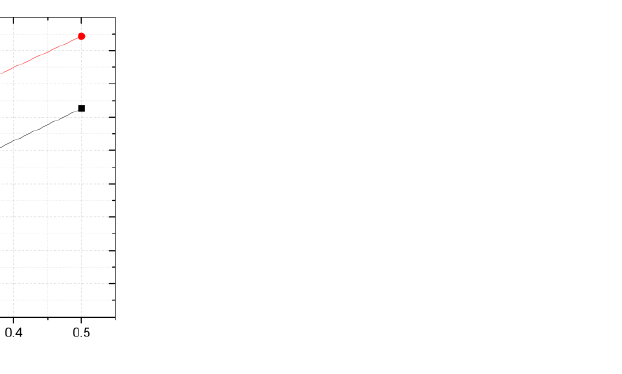
Figure 10. PSNR values of imaging results when DPAP uses different measurement matrices.